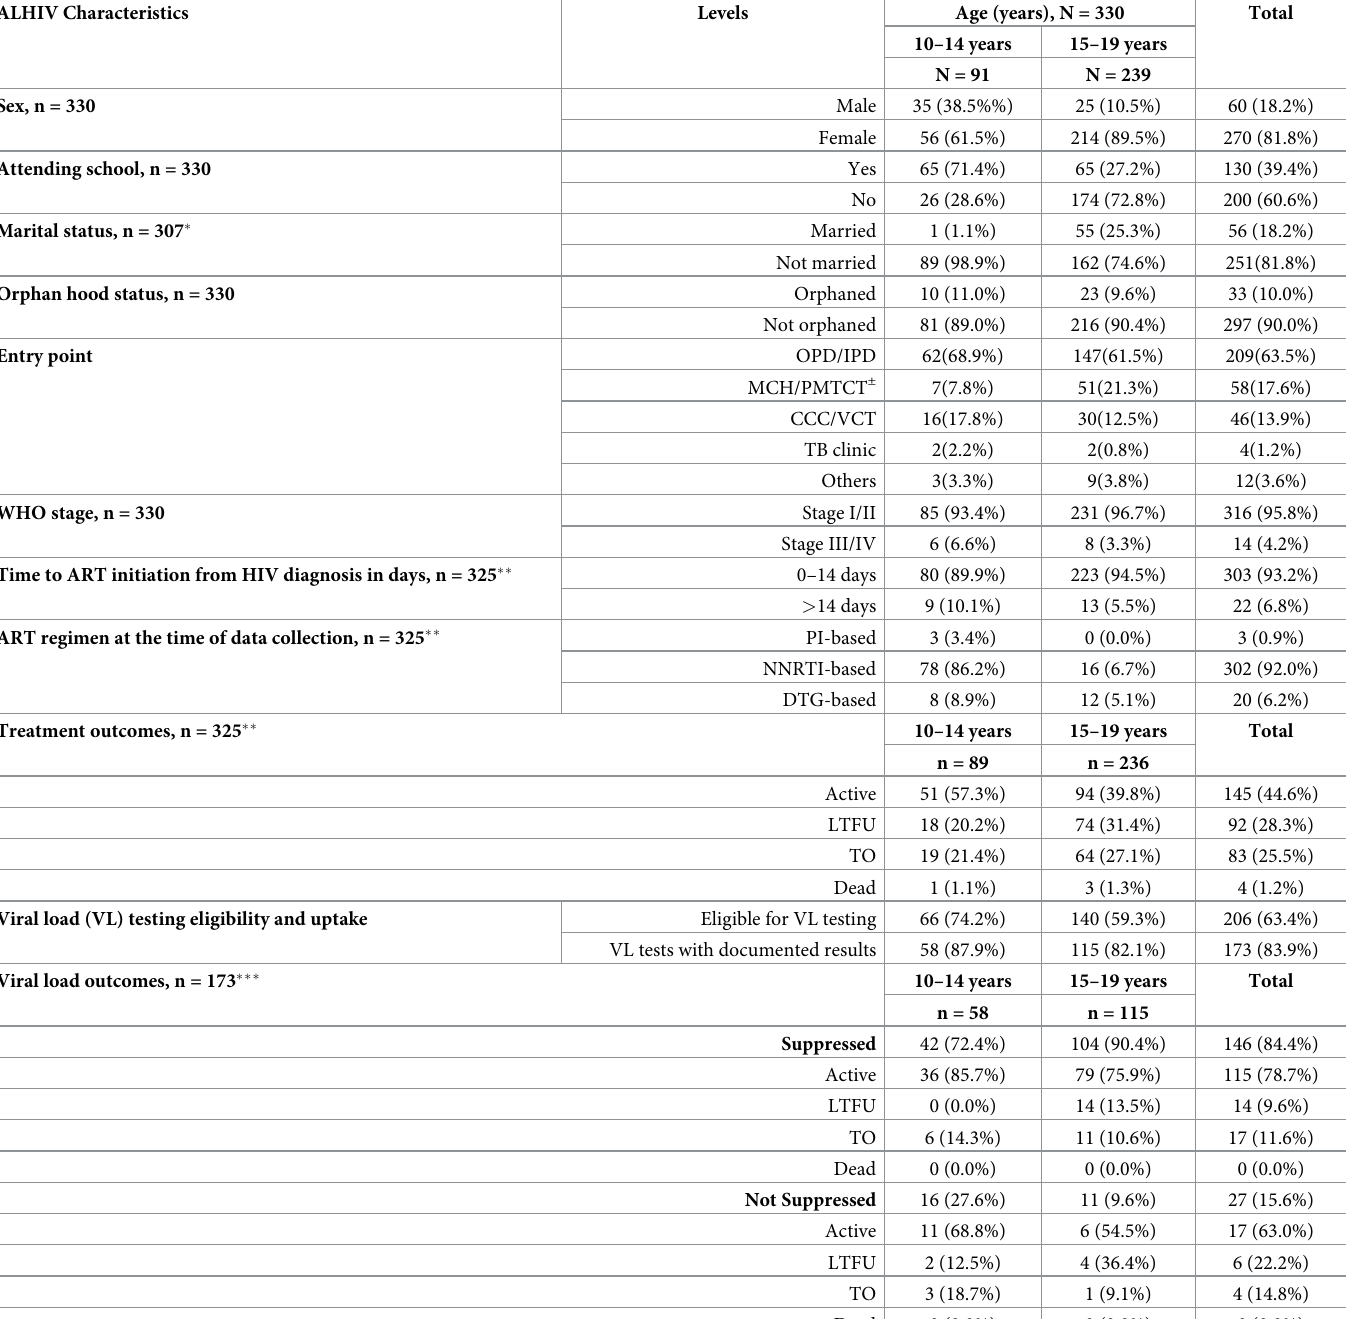
Table 1. Demographic and clinical characteristics of newly diagnosed ALHIV enrolled in care between January 2017 and June 2018 in select HCFs in Homabay and Kakamega Counties. ALHIV